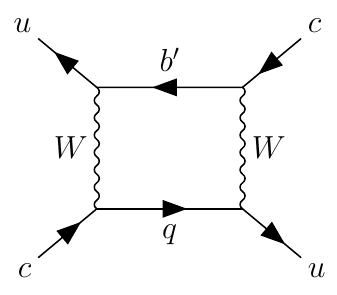
Figure 10 . New contribution to D 0 − ¯ D 0 mixing, q = d, s, b, b 0